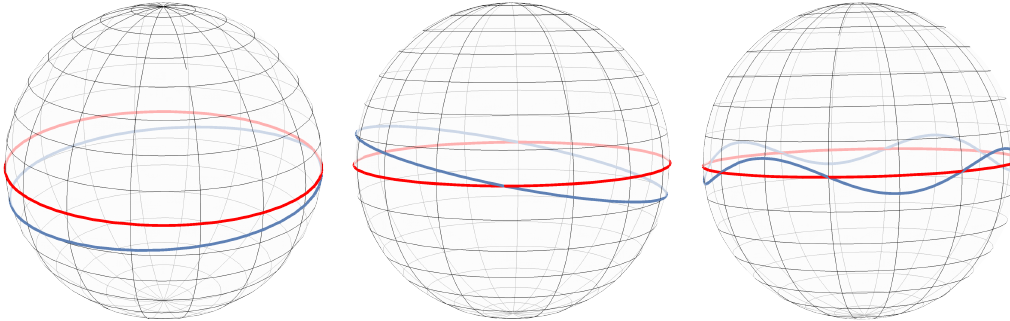
Figure 4 . Unstable mode n = 1 (left), zero mode n = 2 (middle) and massive mode n = 8 (right) for the fluctuations around a geodesic winding once around the sphere